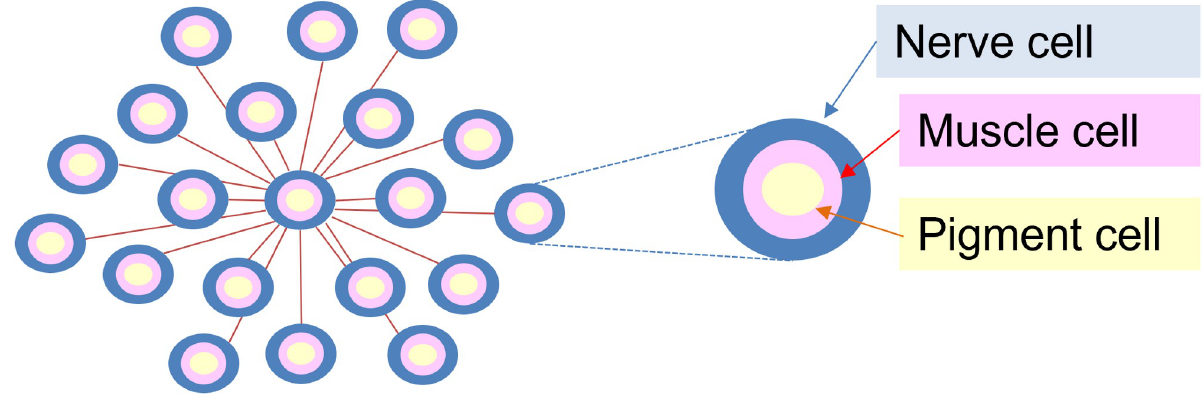
Fig 16. Epidermal cell composition model.